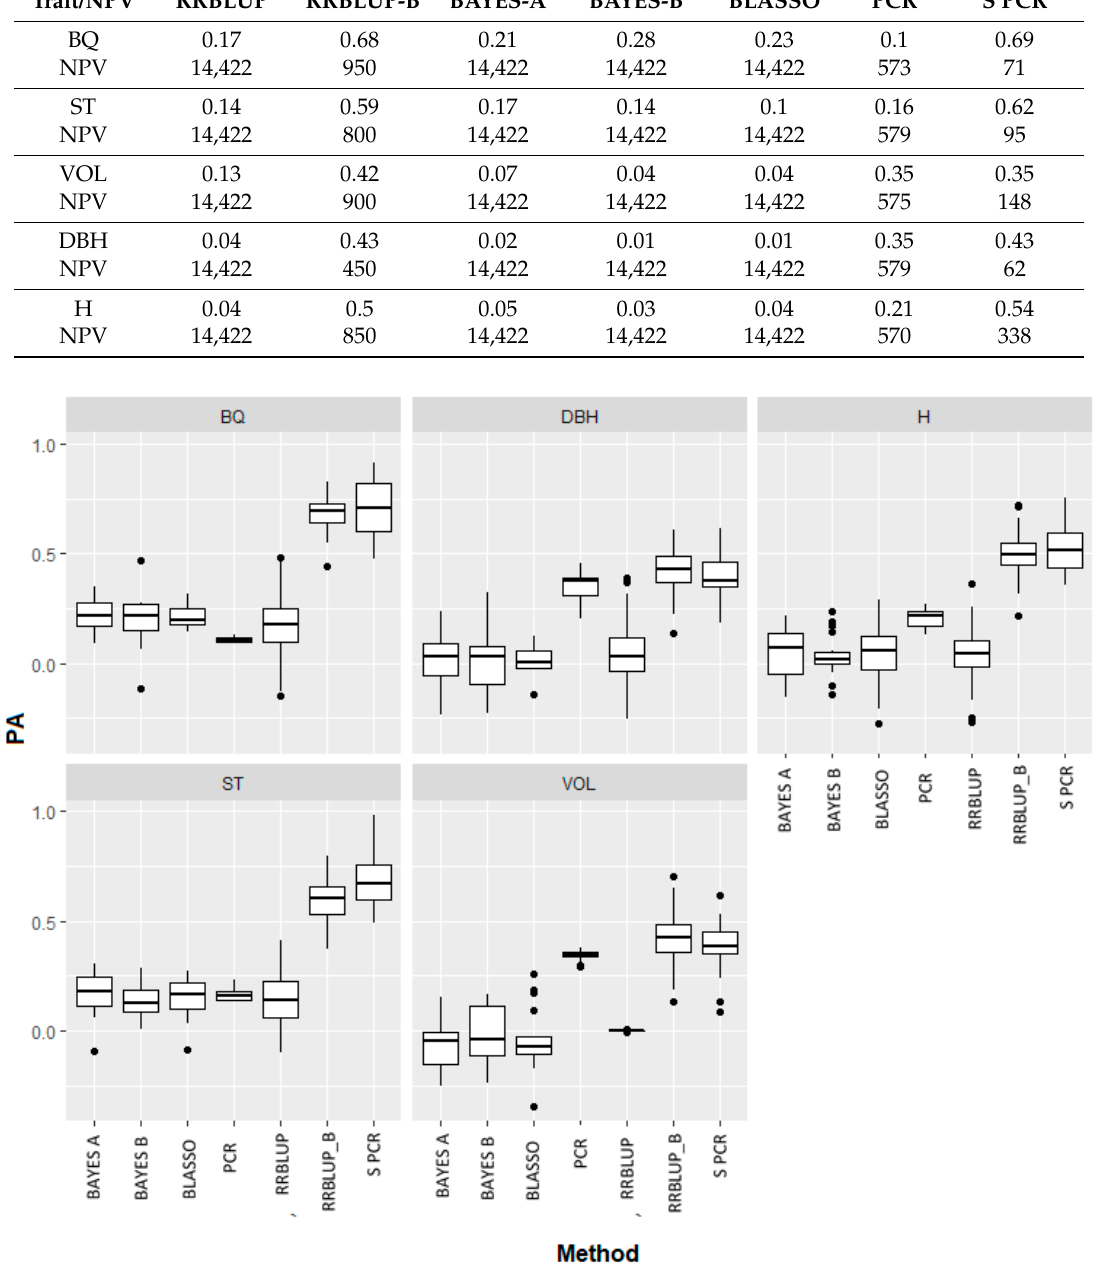
Figure 3. Box plot of adjusted means for the predictive ability (PA) of seven GS methods for branching quality (BQ), stem straightness (ST), wood volume (VOL), diameter at breast height (DBH) and tree height (H).